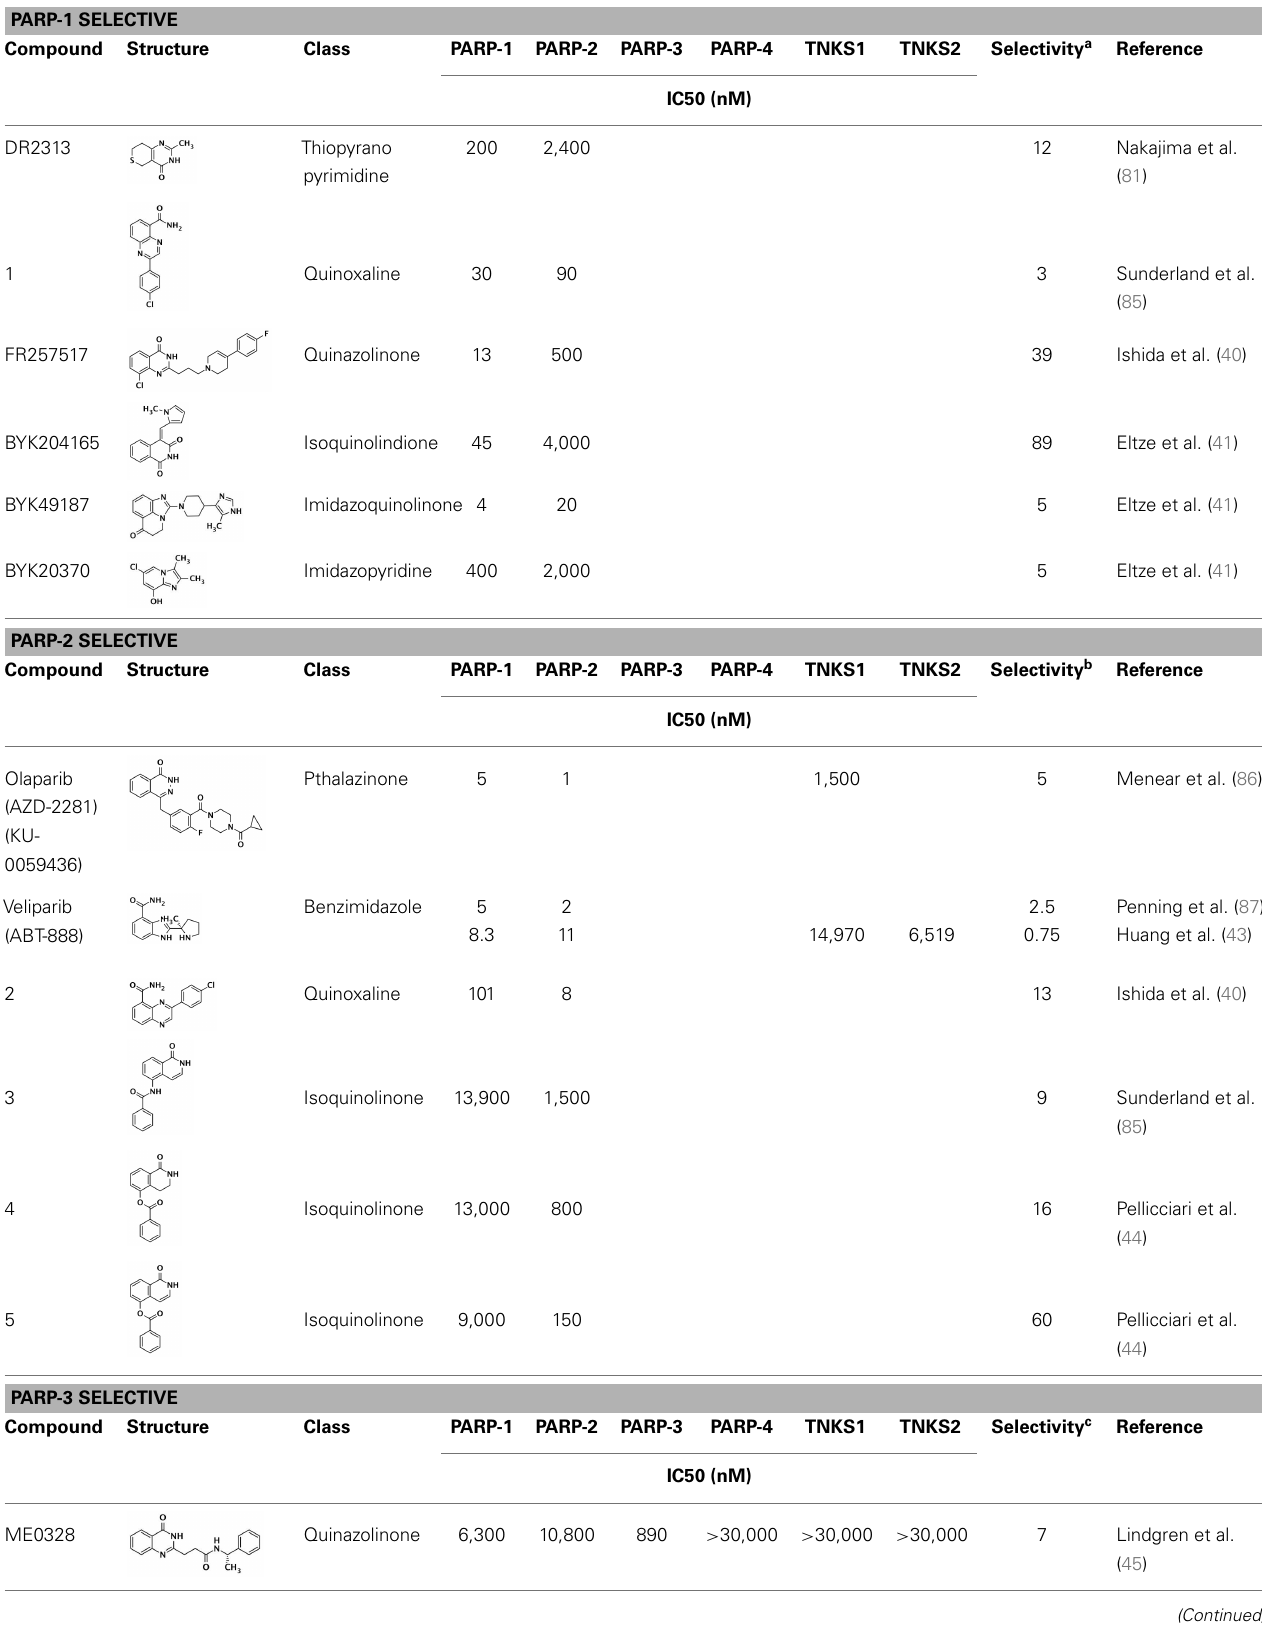
Table 1 | Selectivity of PARP inhibitors. Published IC50 values of PARP inhibitors that have been tested against multiple PARPs . PARP-1